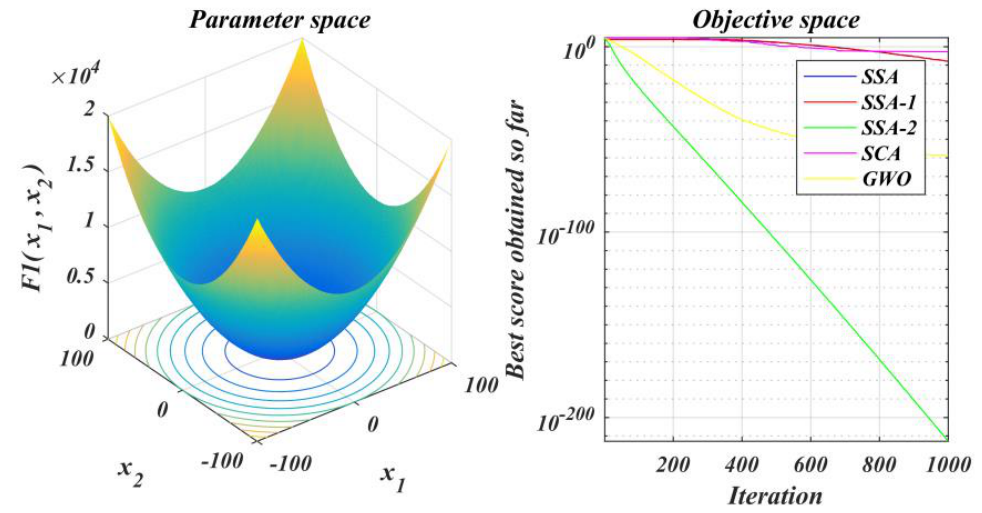
Figure 3. F1 Convergence curve.